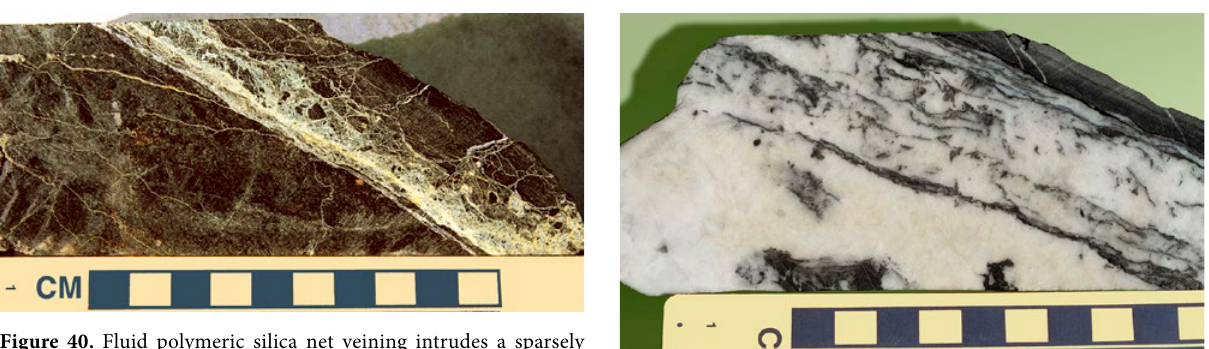
Figure 40. Fluid polymeric silica net veining intrudes a sparsely mineralised section of the Kaiser prospect core near Orange, NSW. It shows a number of features resembling the intrusion of a clastic dyke. It has been formed by hydraulic expansion of the vein space so that angular fragments are rotated and slivers of cohesive sedi- ment parted from the margins. This type of fluid vein is transitional to a clastic dyke.